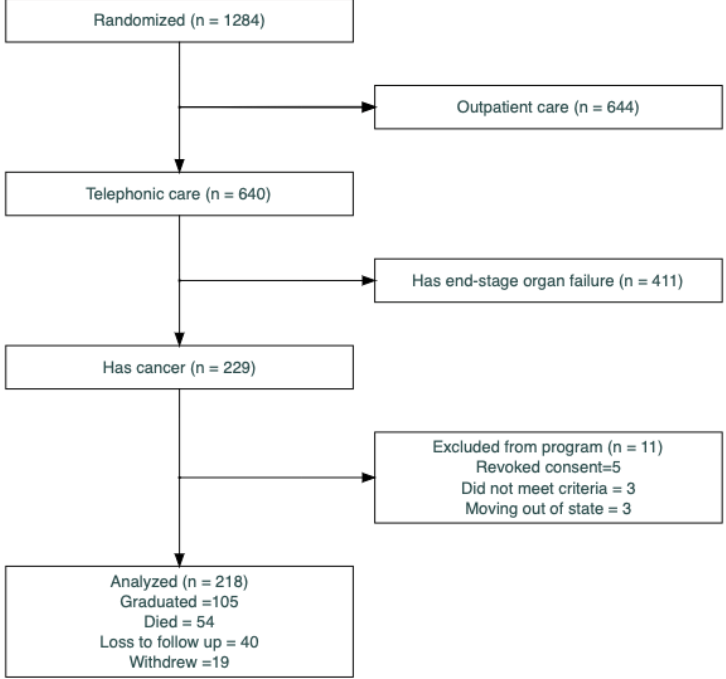
Figure 1. Consolidated Standards of Reporting Trials (CONSORT) diagram.